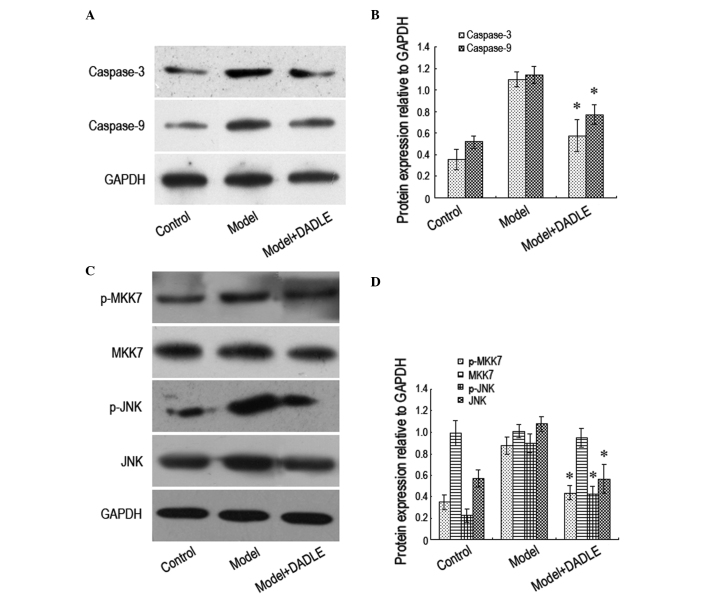
Effects of DADLE on the expression levels of pro-apoptotic proteins caspase-3 and caspase-9 and the expression levels of MKK7 and JNK in intestinal epithelial cells subjected to ischemia/reperfusion. (A) Protein expression levels of caspase-3 and caspase-9 were determined using western blotting. (B) Western blotting results were analyzed using Gel-Pro Analyzer 4.0 software. (C) Protein levels of p- and total MKK7 and JNK were analyzed using western blotting. (D) Western blotting results were analyzed using Gel-Pro Analyzer 4.0 software. *P<0.01, compared with the model group. Each independent experiment was repeated in triplicate. Data are presented as the mean ± standard deviation. DADLE, (D-Ala2, D-Leu5)-enkephalin; Model, ischemia/reperfusion. p-, phosphorylated; MKK, mitogen-activated protein kinase kinase; JNK, c-Jun N-terminal kinase.